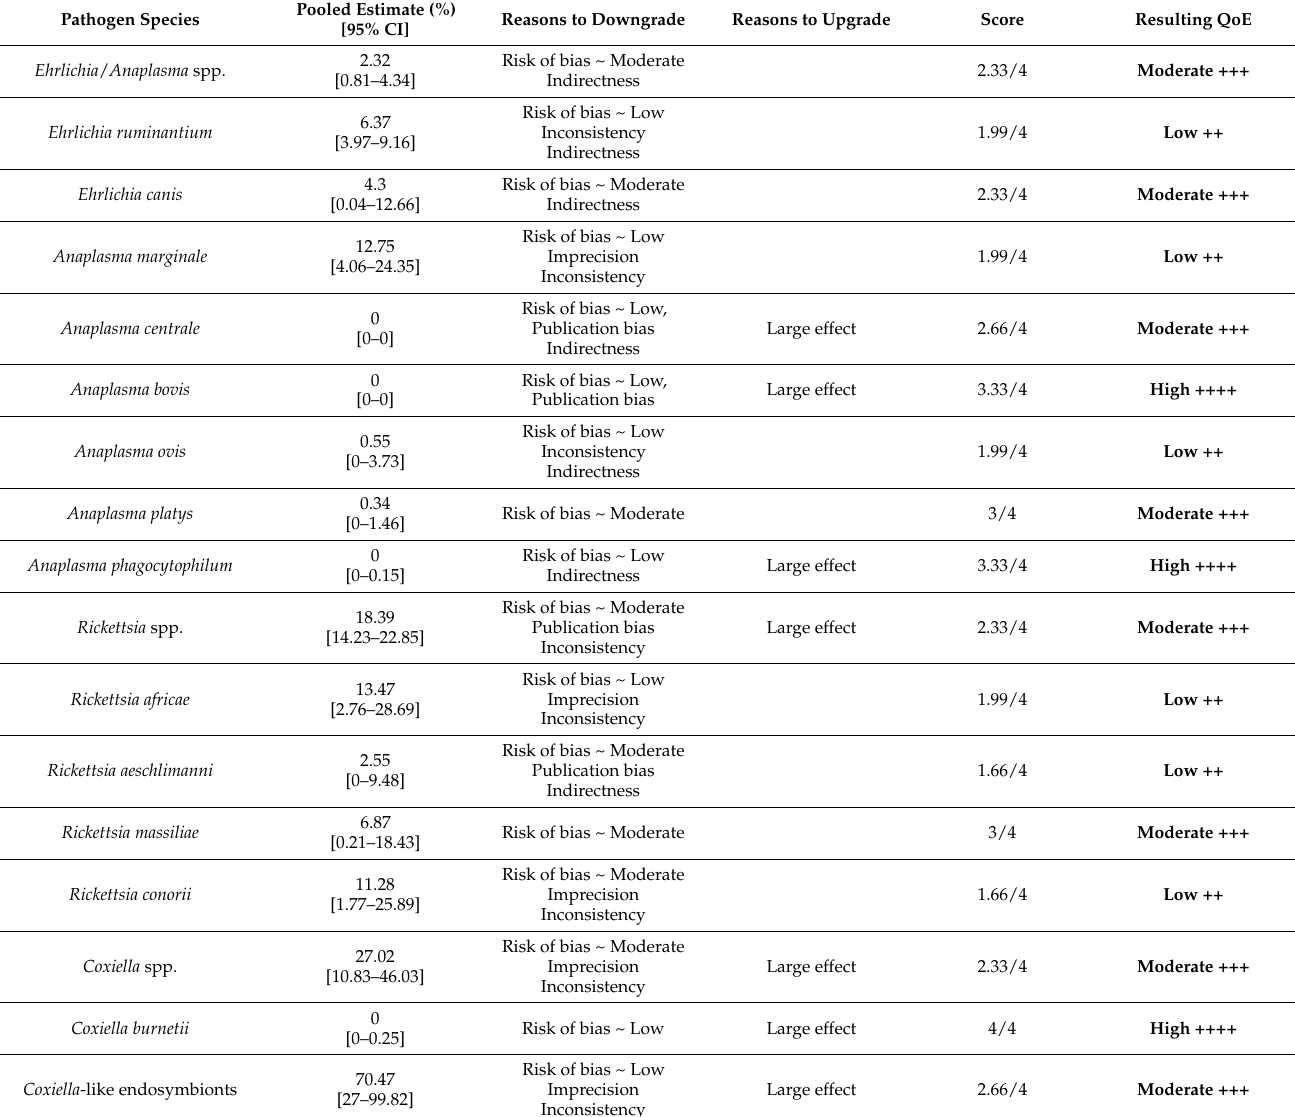
Table 7. Quality of Evidence (QoE) for our prevalence